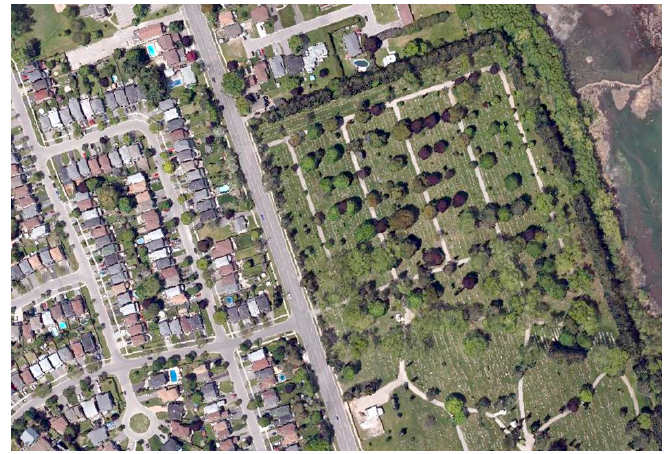
Figure 5. Ortho-rectified aerial image of the study area.